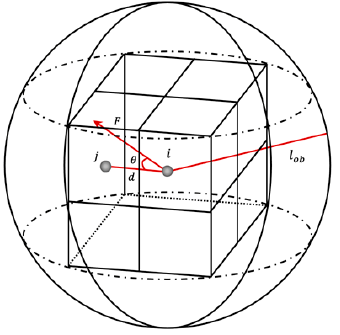
Figure 3. Pheromone diffusion model.